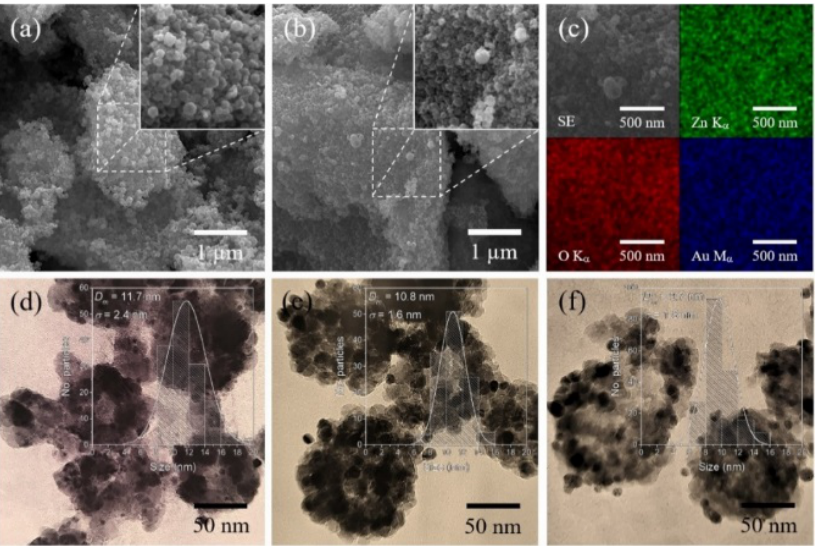
Figure 3. ( a ) FE-SEM micrograph of the ZnO support, ( b ) FE-SEM micrograph, and ( c ) elemental mappings of a representative gold-loaded sample (Progressive heating). TEM images of the samples obtained using ( d ) Direct Turkevich Method, ( e ) Inverse Turkevich Method, and ( f ) Progressive Heating Method and their corresponding particle size histogram of Au-NPs.